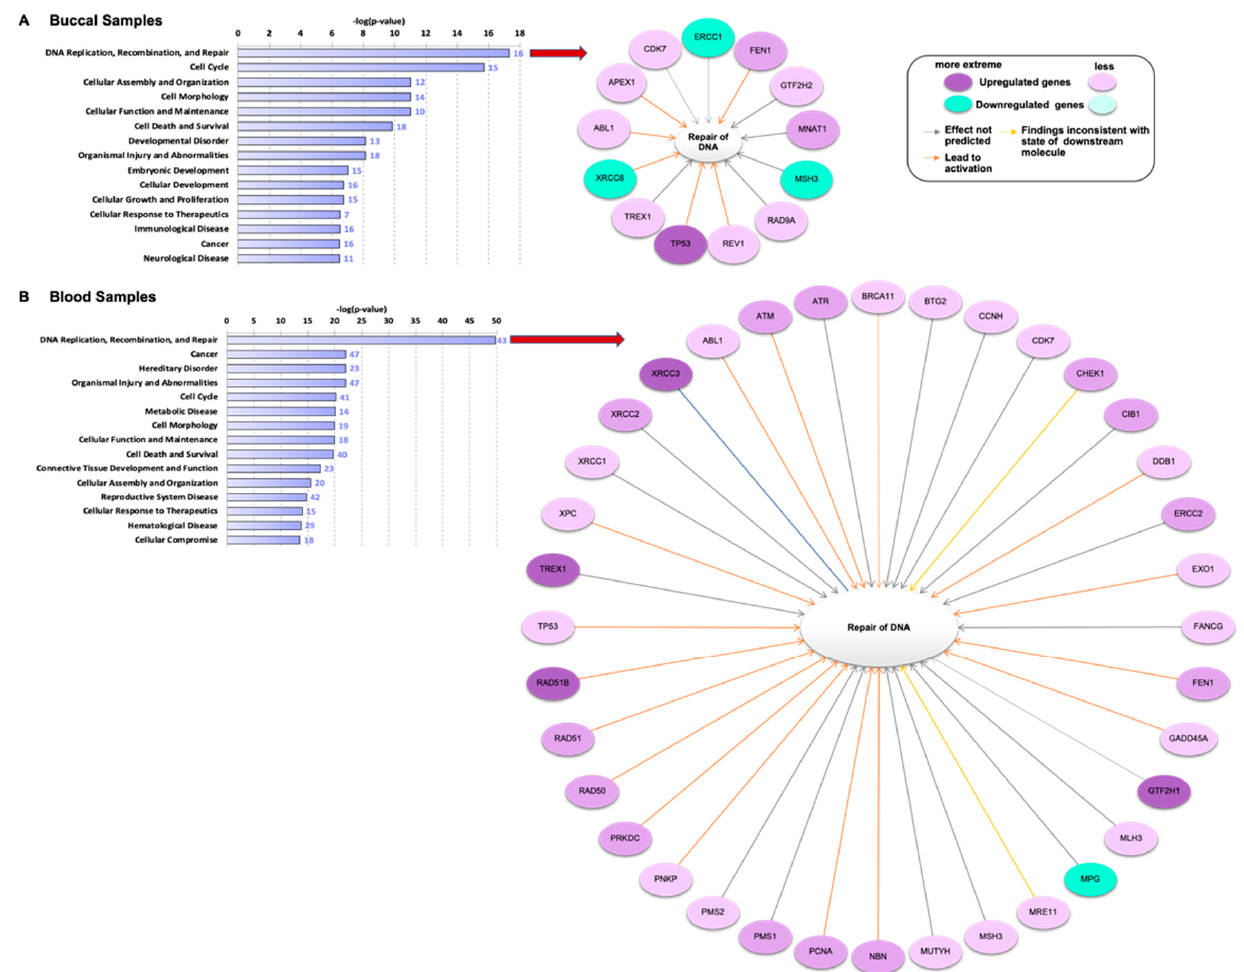
Figure 2. Top 15 significantly ( p < 0.05) pathways triggered after e-cig exposure. ( A ) Results of ingenuity pathway analysis showing the most significant biological functions in buccal and ( B ) blood samples, following vaping for three subjects across the three visits. The numbers at the end of each bar represent the number of genes involved in the pathway. Genes associated with DNA repair pathway are presented in the network analysis. Cell cycle was the second most significant pathway activated after e-cig exposure in buccal epithelium, while in blood, cancer was the second most significantly triggered pathway following e-cig exposure.